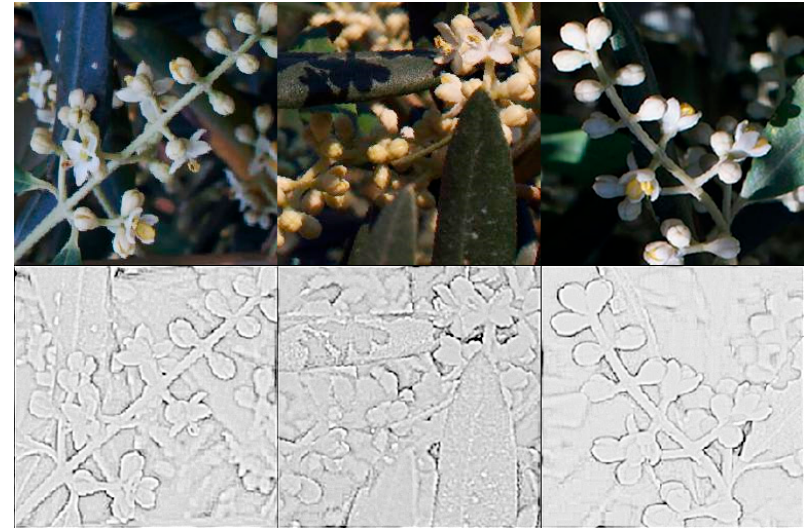
Figure 5. Application of the phase stretch transform (PST) algorithm.